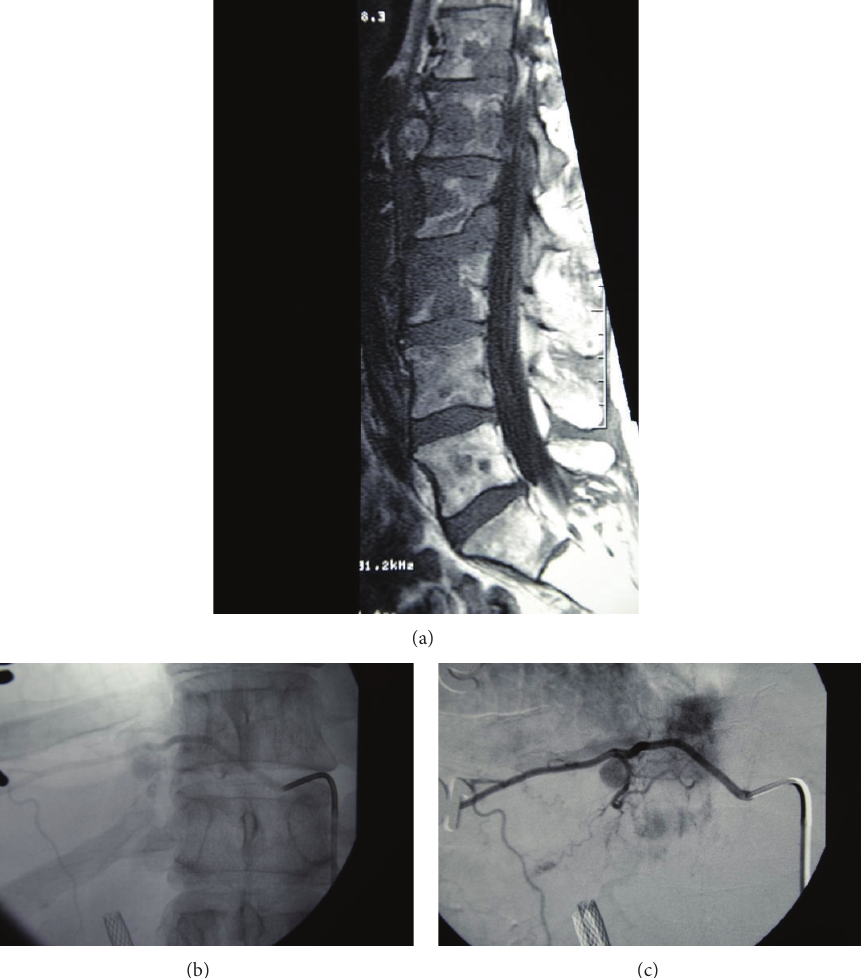
Figure 3: Case 2—widespread involvement of metastatic pheochromocytoma as seen on noncontrast T1 magnetic resonance sagittal image (a). Unsubtracted (b) and subtracted (c) anterior-posterior superselective angiographic run immediately prior to infusion of cisplatin into the left T11-T12 spinal artery. Note the extensive tumor blush, neovascularity, and paraspinal tumor nodule. A hepatobiliary stent is also